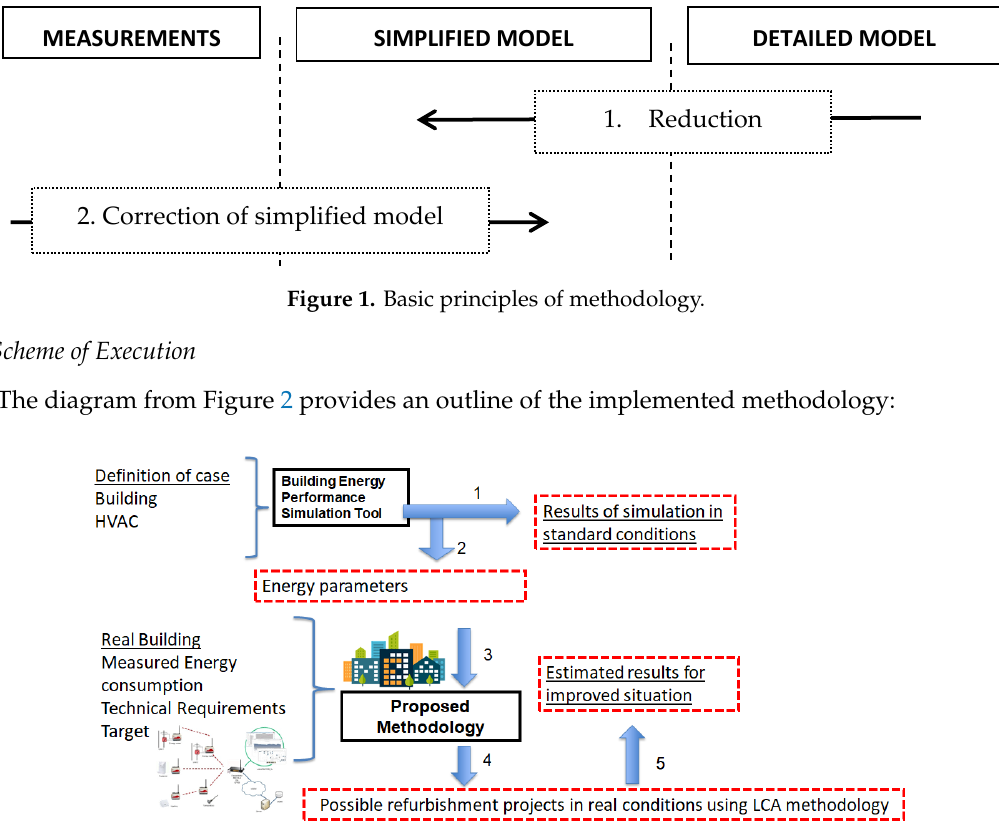
Figure 2. Scheme of methodology.